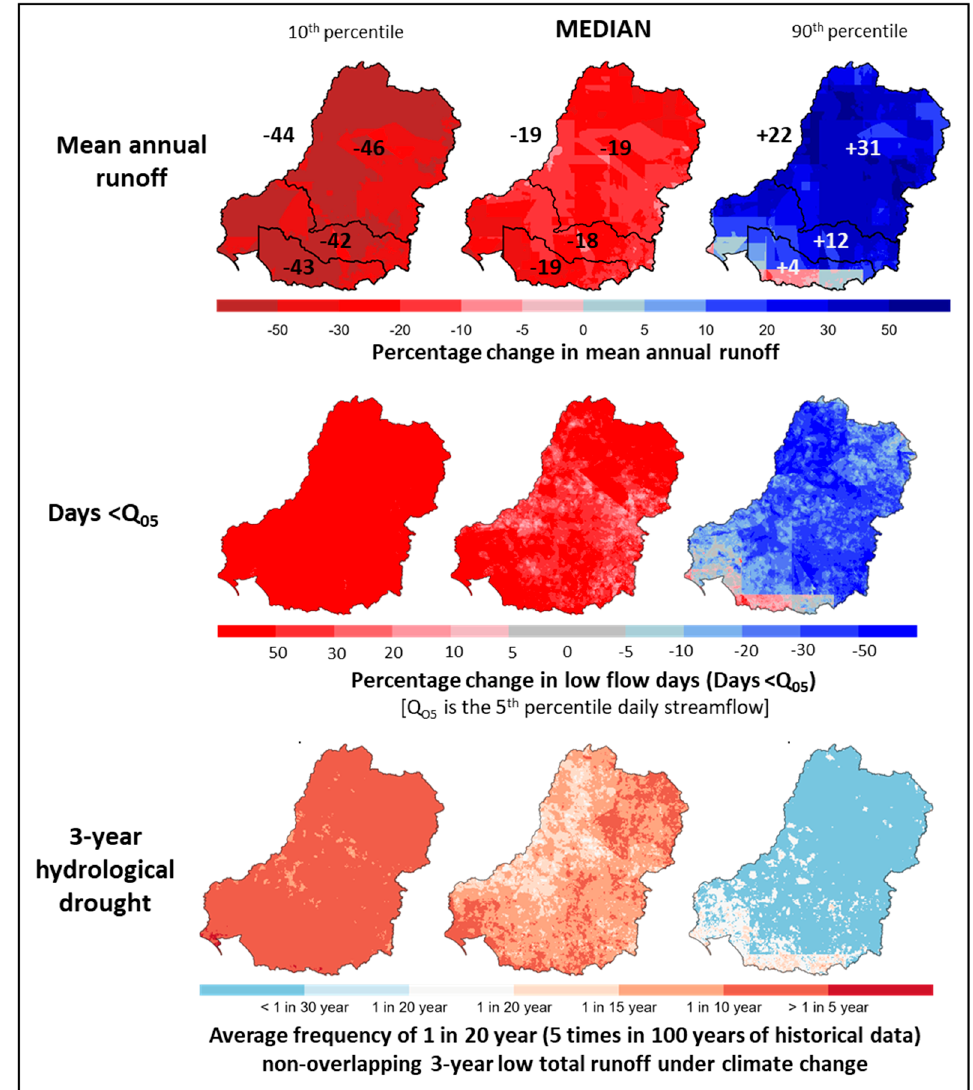
Figure 2. Projected change in streamflow characteristics for 2046–2075 relative to 1976–2005 for the high RCP8.5 emissions scenario (representative of projected change under a 2 °C global average warming). Data from [43,4450].